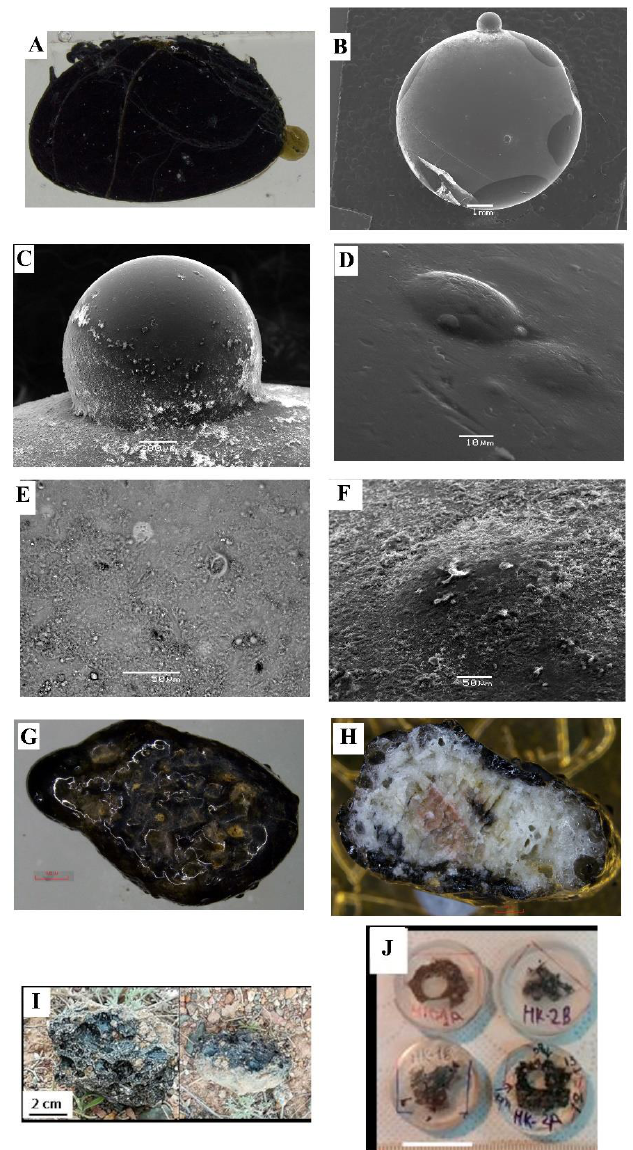
Figure 1. Appearance of the samples of the three studied groups. Group I — ( A – E ); Group II — ( G , H ); Group III — ( I , J ). ( A ) Optical image of a polished half of the sample R1 embedded in epoxy resin; ( B ) SEM-SE images of R1: general view (scale bar 1 mm); ( C ) enlarged image of the small bead on the surface; ( D ) smaller beads; ( E , F ) features of high-temperature etching, note the boundary between the etched and smooth surface in ( E ); ( G , H ) optical images of particles of the Group II (“kharitonka”); ( G ) outer appearance; ( H ) polished cross-section; ( I ) optical photographs example of top and side view of the black ground glass samples (Group III, HK); ( J ) epoxy resin tablets with embedded fragments of the “HK” samples. Group I: Aerodynamic glassy fallout particles represented by specimen #R1 (Figure 1A – F). The sample is a fully vitrified black droplet with a glassy luster, shaped like a flattened sphere ~1 cm in diameter. Several small (<1 mm) glassy beads are attached to the